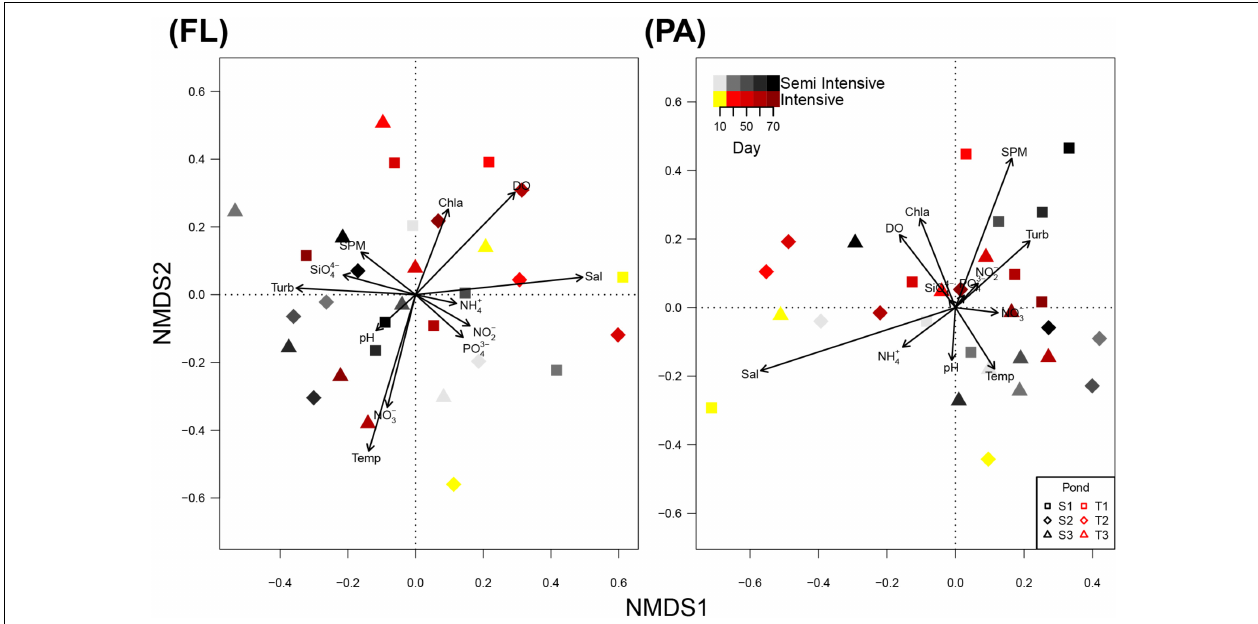
FIGURE 3 | Non-metric multidimensional scaling (NMDS) plot of bacterial community composition (BCC) in the free-living (FL) and particle-attached (PA) fraction. Information on environmental parameters was added to the NMDS plot using envfit. Point shape indicates replicate ponds of the same system. Increasing color intensity indicates rearing time. SPM, suspended particulate matter; NH 4 + , ammonium; Turb, turbidity; Temp, temperature; SiO 44 − , silicate; Sal, salinity; PO 43 + , phosphate; NO 2 − , nitrite; DO, dissolved oxygen; NO 3 − , nitrate; Chl a, chlorophyll a.